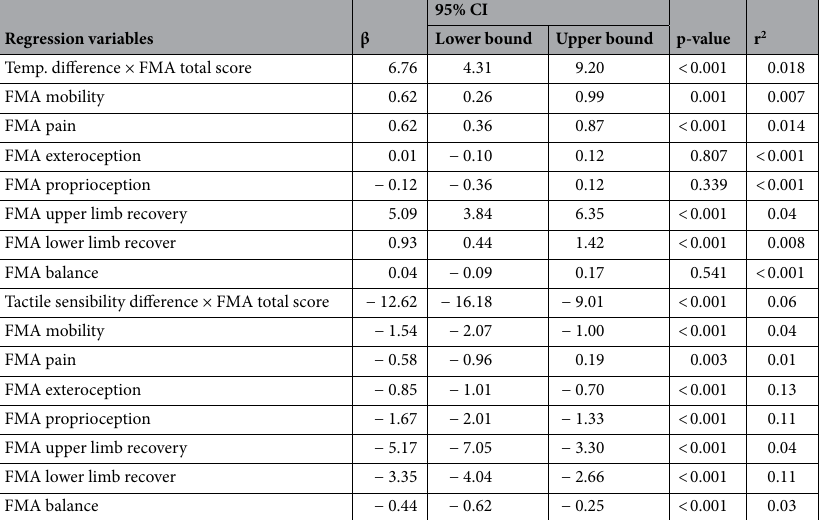
Table 3. Association of sensorimotor recovery and temperature or tactile sensibility differences. β beta coefficient of linear regression, CI confidence interval of beta coefficient, Temp . temperature, FMA